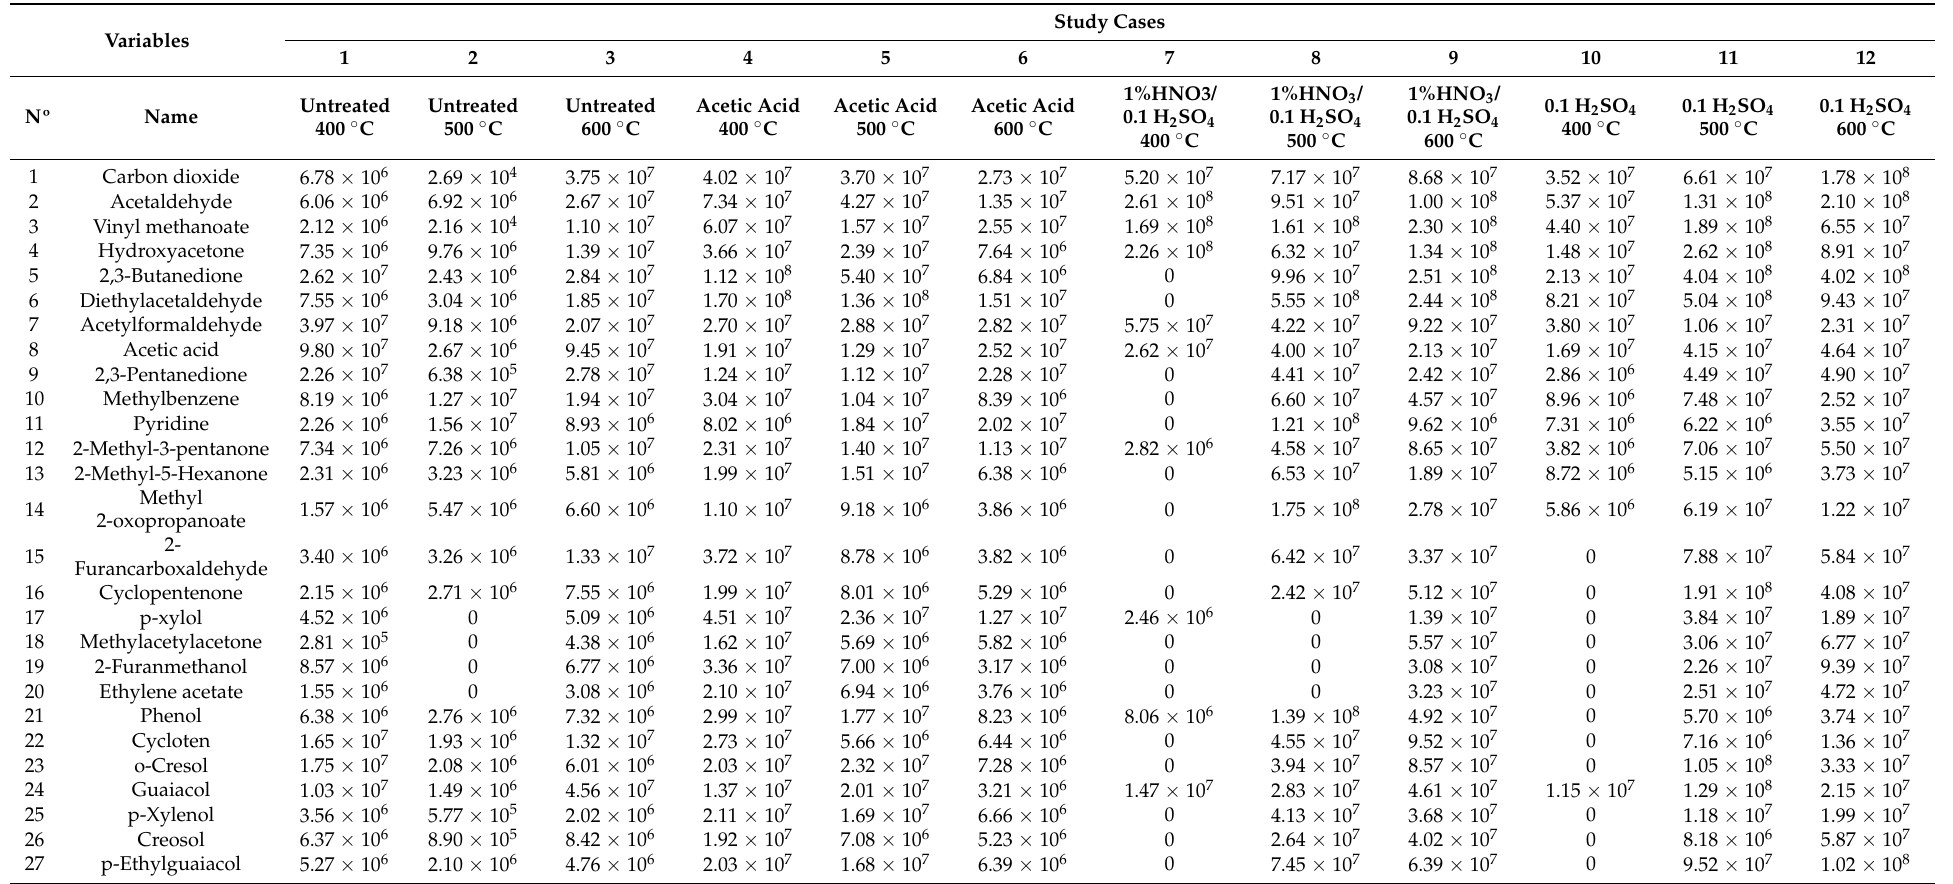
Table A1. Cases and variables used in principal component analysis (PCA) to discriminate the effect of pyrolysis temperature and acid type during biomass